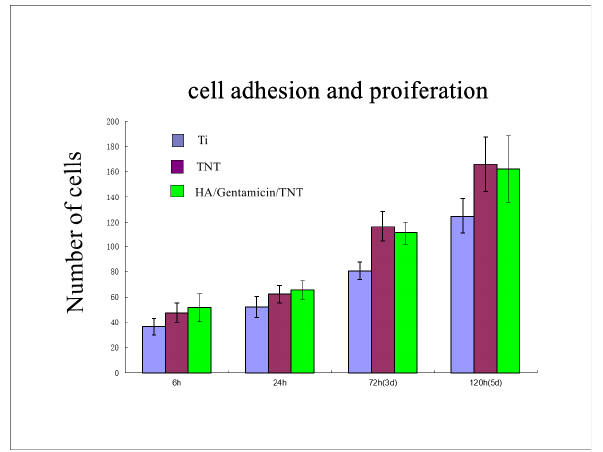
Figure 5. Cell adhesion increased in the TNT and HA/Gentamicin/TNT groups compared to the Cp– Ti group at 6 and 24 h. At three and five days, the cells of the TNT group and HA/Gentamicin/TNT groups had higher proliferation rates compared to the Cp–Ti group. Data = mean ± SD, N =